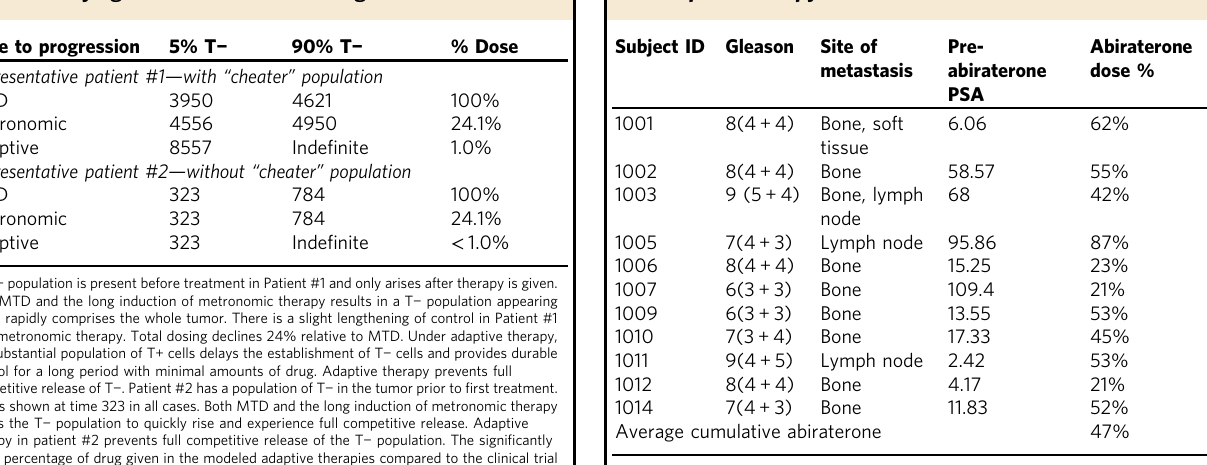
Table 1 Time to different stages of competitive release of T − cells for varying simulated treatment regimens